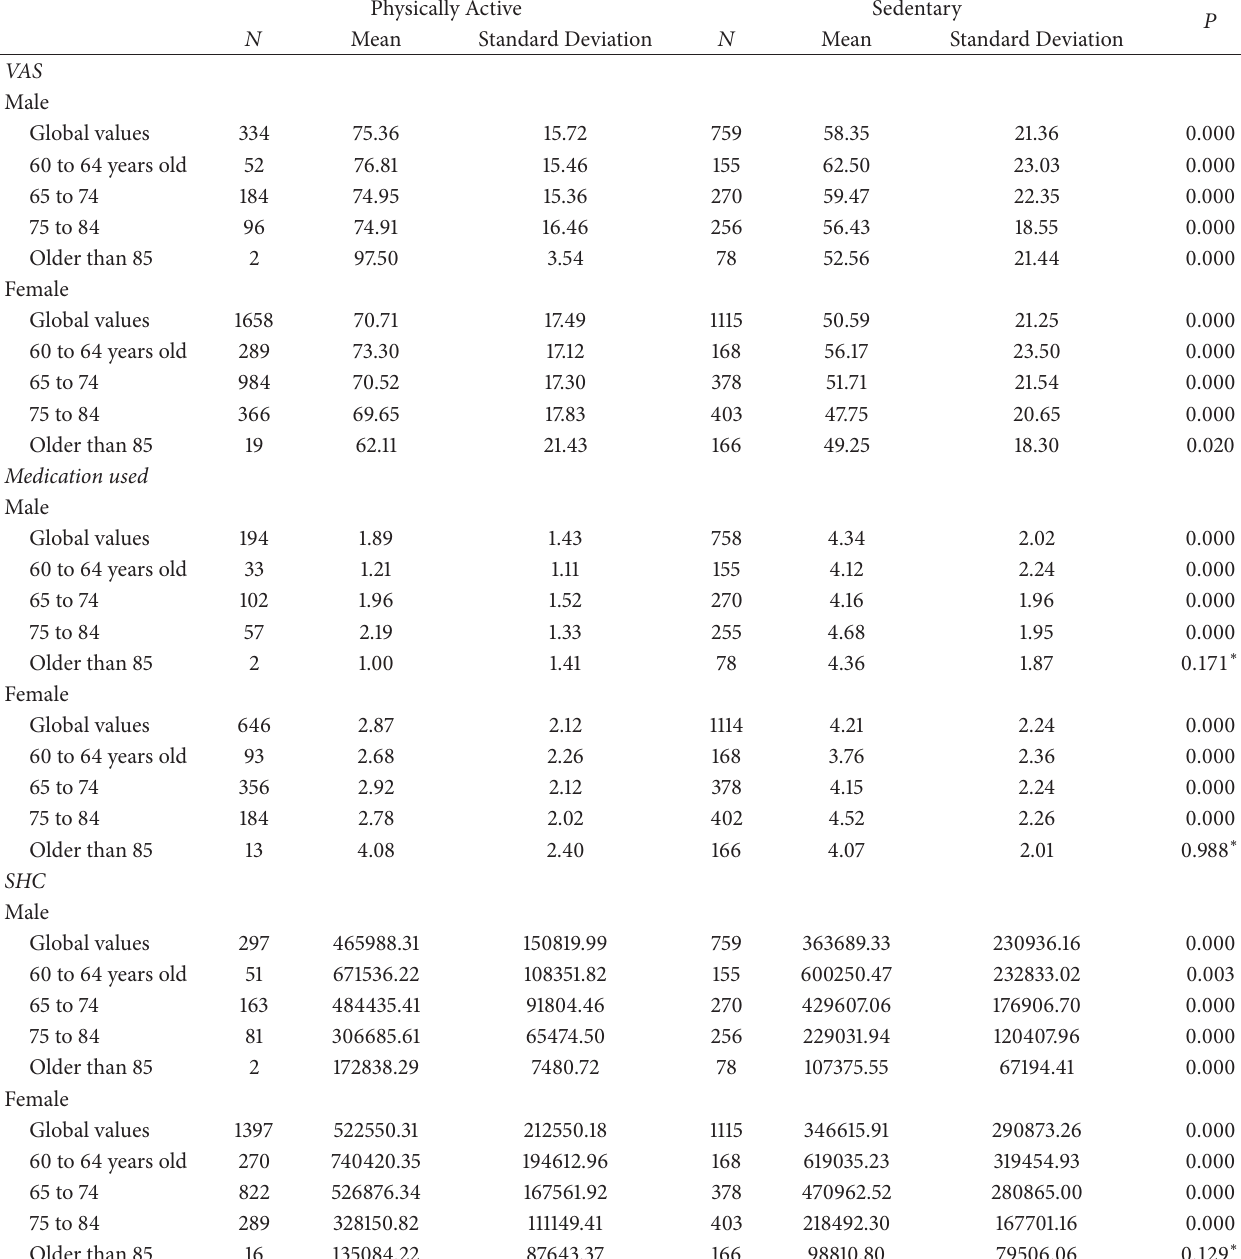
Table 1: Group statistics corresponding to the analysis of VAS, medication used and SHC by gender and age. Physically